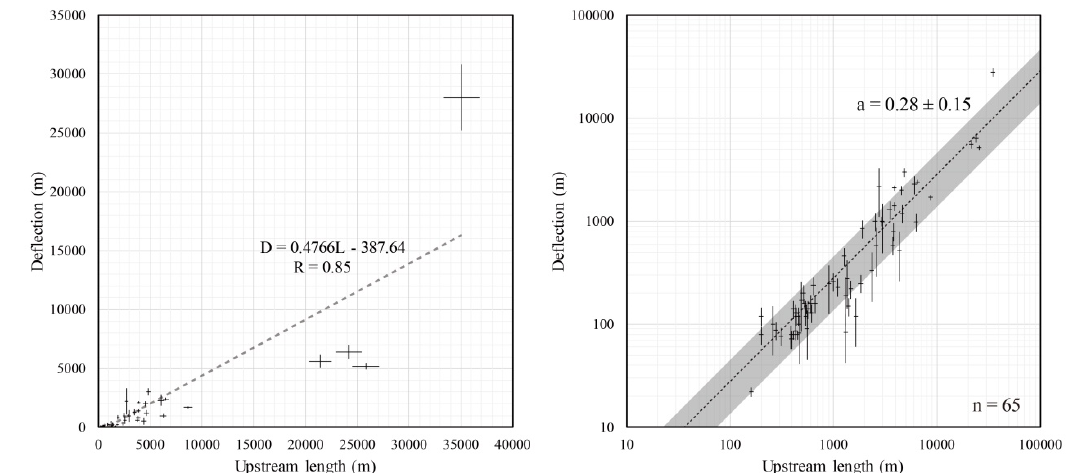
Figure 9. Diagram showing the relationship between the deflection amount (D) and the upstream channel length (L) of bedrock channels. The statistical results of 65 channels indicate a good linear relationship with correlation coefficient of 0.85 (the left one is linear coordinate system, and the right one is double logarithmic coordinate system).